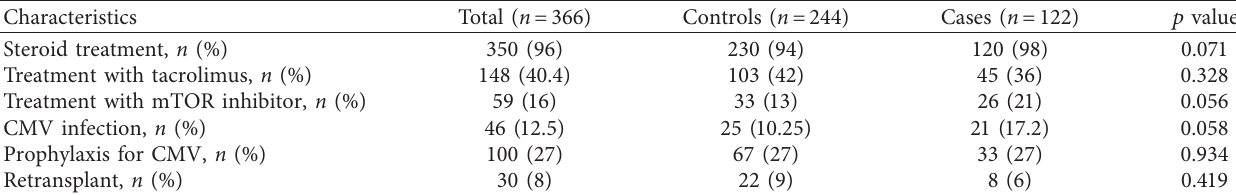
Table 2: Risk factors for NODAT in patients with renal transplantation between 1995 and 2014.